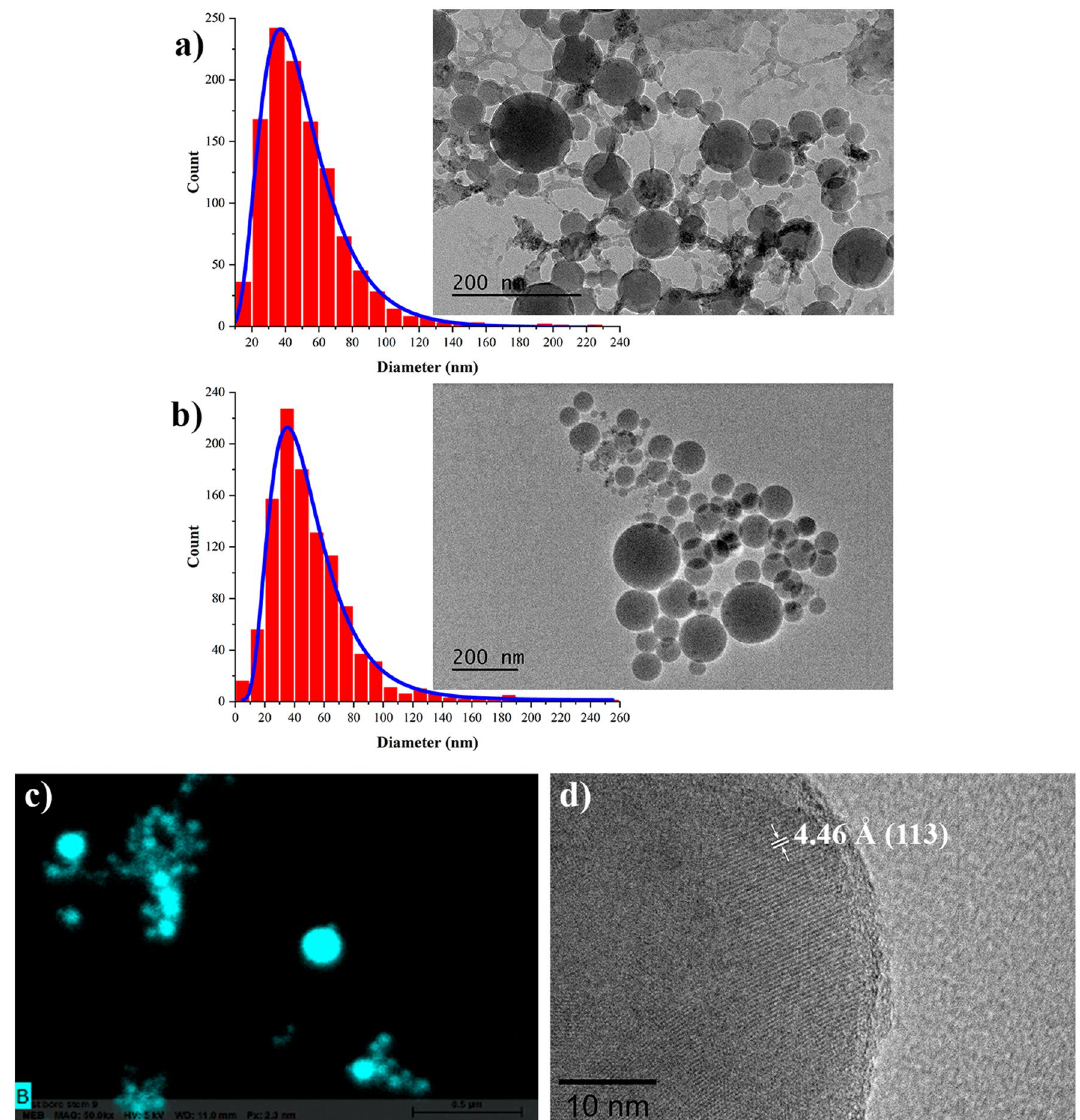
Figure 2. High resolution electron microscopy images of laser-synthesized NPs: ( a ) Typical TEM image (inset) and corresponding size distribution of as-prepared boron-based NPs. ( b ) Typical TEM image (inset) and corresponding size distribution of boron NPs after multiple centrifugation and purification steps. ( c ) Typical EDX map of NPs prepared by fs laser ablation in water. Cyan color corresponds to boron. ( d ) HR-TEM image of a polycrystalline